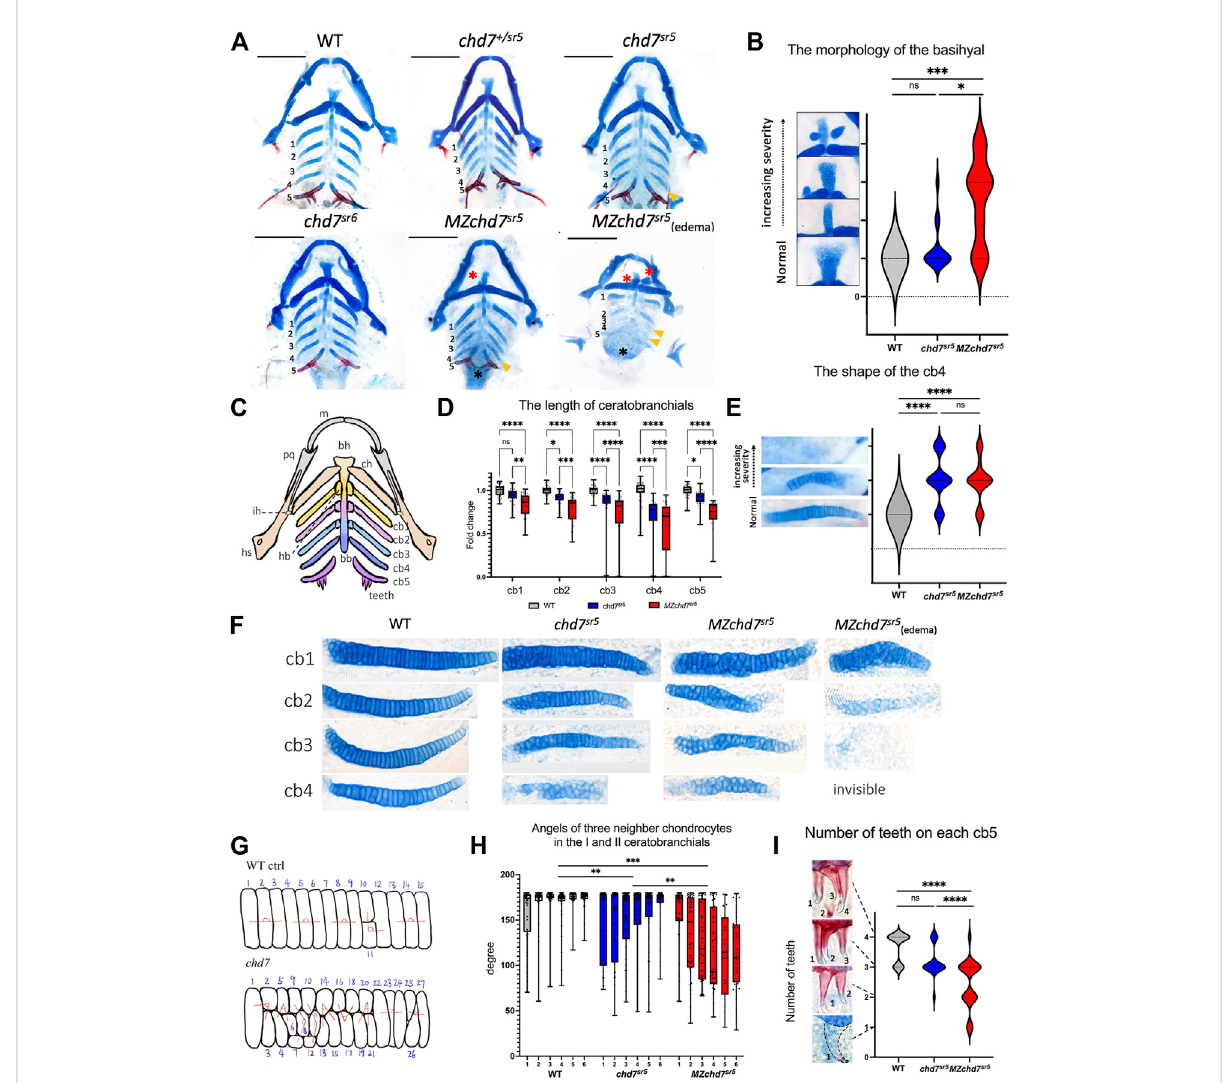
FIGURE 3 Craniofacial phenotype characterization in chd7 sr5 mutants. (A) Viscerocranium morphology. The viscerocranium was dissected out from the Alcian blue and Alizarin red costained WT, chd7 sr5 , and MZchd7 sr5 mutants with or without heart edema at 7 dpf. Yellow arrowheads indicate the reduction in the IV ceratobranchial; black asterisks mark the defects in the teeth; red asterisks mark the abnormalities in the basihyal. (B) Quanti fi cationofthedifferenttypesofthemorphologyofbasihyalinWT, chd7 sr5 ,and MZchd7 sr5 .(WT: n =16; chd7 sr5 : n =16; MZchd7 sr5 : n =15). Thestatisticalanalysiswasperformedusingthechi-squaretest. (C) Schematicoftheviscerocraniumcartilageat7 dpf.bb,basibranchial;bh,basihyal; cb,ceratobranchial;ch,ceratohyal;hb,hypobranchial;hs,hyosymplectic;ih,interhyal;m,Meckel ’ s;andpq,palatoquadrate. (D) Quanti fi cationofthe length of I to V ceratobranchials in WT, chd7 sr5 , and MZchd7 sr5 . (WT: n = 24; chd7 sr5 : n = 20; MZchd7 sr5 : n = 23). The statistical signi fi cance was performedusingtheordinaryone-wayANOVAtest. (E) Quanti fi cationofdifferenttypesofthemorphologyoftheIVceratobranchial.( n =22foreach group). The statistical analysis was performed using the chi-square test. (F) High-magni fi cation image shows that chondrocyte stacking is disrupted in chd7 sr5 mutants,andseverelydisorganizedstackinghasbeenfoundin MZchd7 sr5 mutants. (G) Schematicofchondrocytes ’ stackingmeasurement. (H) AnglesofthreeneighborchondrocytesinIandIIceratobranchials.Eachnumberindicatesadifferent fi sh.( n =6foreachgroup).Thesigni fi cance was calculated between different groups. chd7 sr5 mutants have mild disorganization in the chondrocyte arrangement, but MZchd7 sr5 mutants have more severe defects in the chondrocytes. The statistical analysis was performed using the ordinary one-way ANOVA test. (I) Alizarin red-stained teetharereducedin chd7 sr5 mutants at7 dpf.Nearly50%of MZchd7 sr5 fi shhavedefectsinteethnumber.(WT: n =23; chd7 sr5 : n =20; MZchd7 sr5 : n = 38). The statistical signi fi cance was performed using the chi-square test. ns: p ≥ 0.05, *: p < 0.05, **: p < 0.01, ***: p < 0.001, and ****: p <